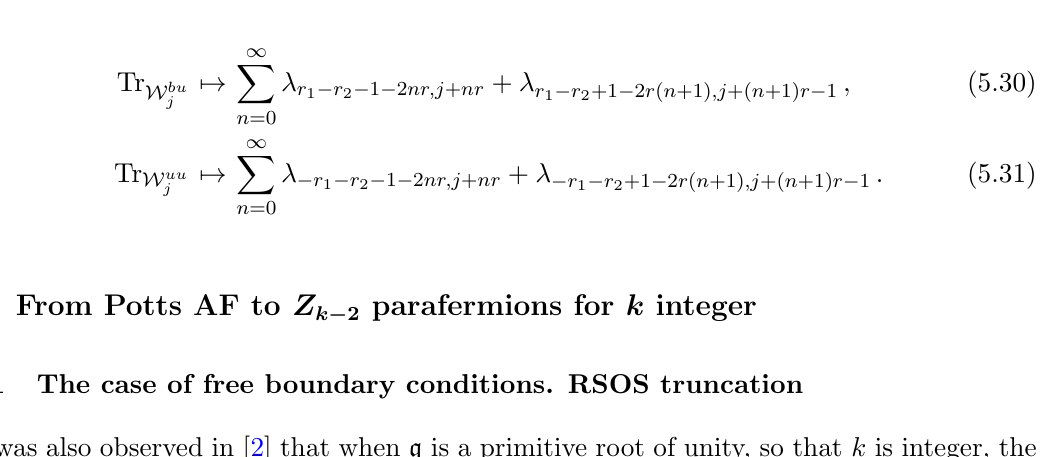
Figure 16 . Alt on both sides: anti-correlated boundary conditions in the bu sector with j =